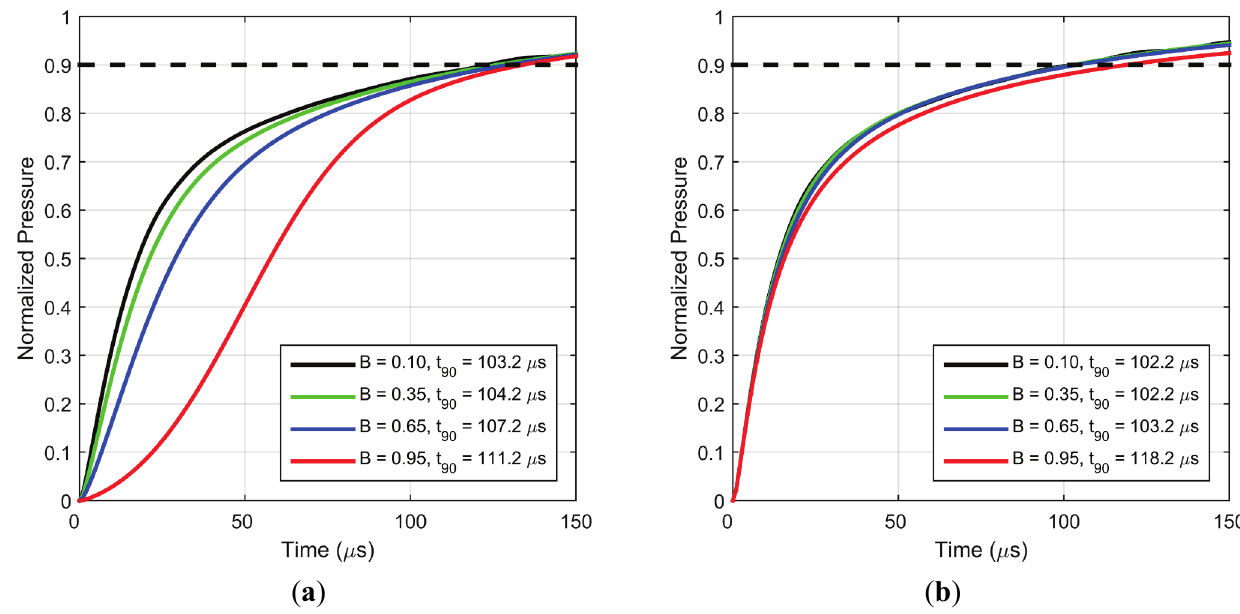
Figure 16. Simulated pressure response for ( a ) step increase in pressure from vacuum to 1 atm. and ( b ) step decrease in pressure from 1 atm. to vacuum, for different values of